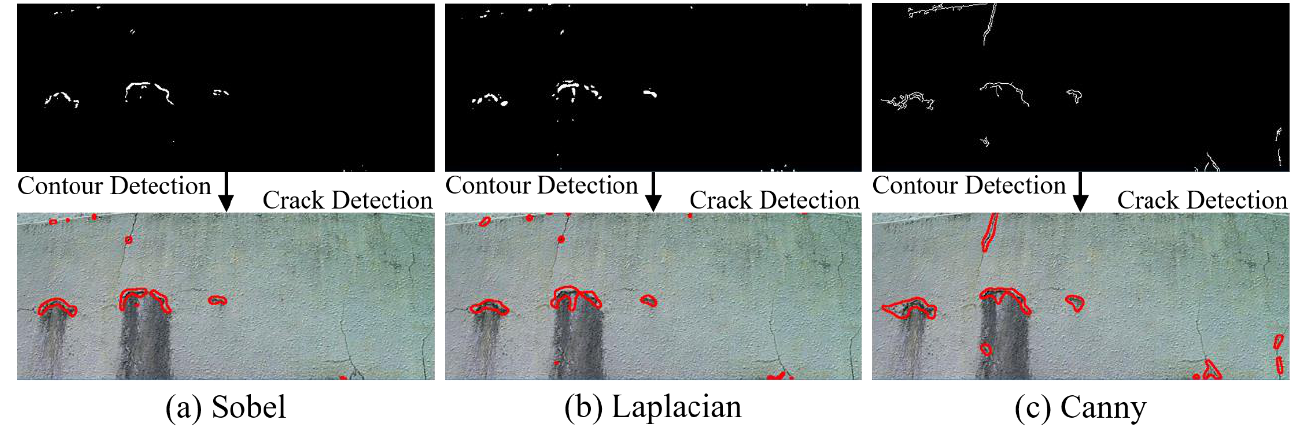
Figure 12. Comparison of the crack detectors on the images. False negative rates for Sobel, Laplacian, and Canny were 0.5, 0.5, and 0, respectively. The average run time of 10 runs of Sobel, Laplacian, and Canny contour detectors was 20.3 ms, 40.1 ms and 11.4 ms. In terms of low computational overhead and accuracy, the Canny contour detector was selected for the anomaly detection